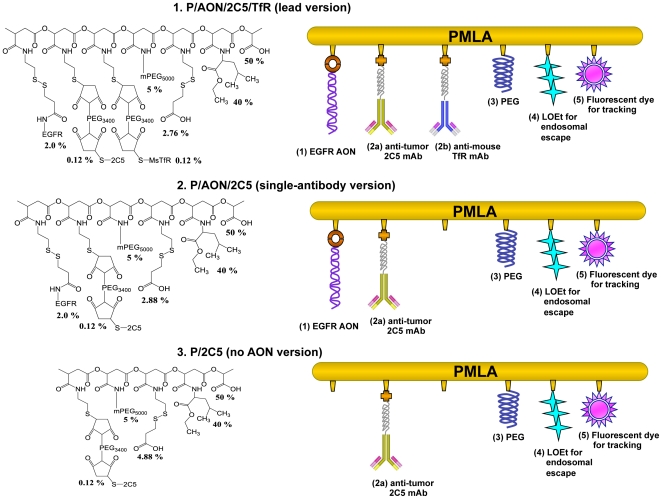
Nanobioconjugate schematic.The new version of nanobioconjugate was designed to inhibit EGFR expression by Morpholino AON in vitro and in vivo. The components are Morpholino AON to EGFR (1) conjugated to the scaffold by disulfide bonds that are cleaved by glutathione in the cytoplasm to release the free AONs; targeting antibodies 2C5 and TfR either alone or as a combination of mAbs to tumor cells (2a), mouse TfR (2b) for tumor endothelial and cancer cell targeting, and receptor-mediated endocytosis; PEG for drug protection (3); L-leucine ethyl ester together with polymer-COOH (4) for endosomal escape of the drug, and optional fluorescent reporter dye (fluorescein or Alexa Fluor 680) for imaging (5).